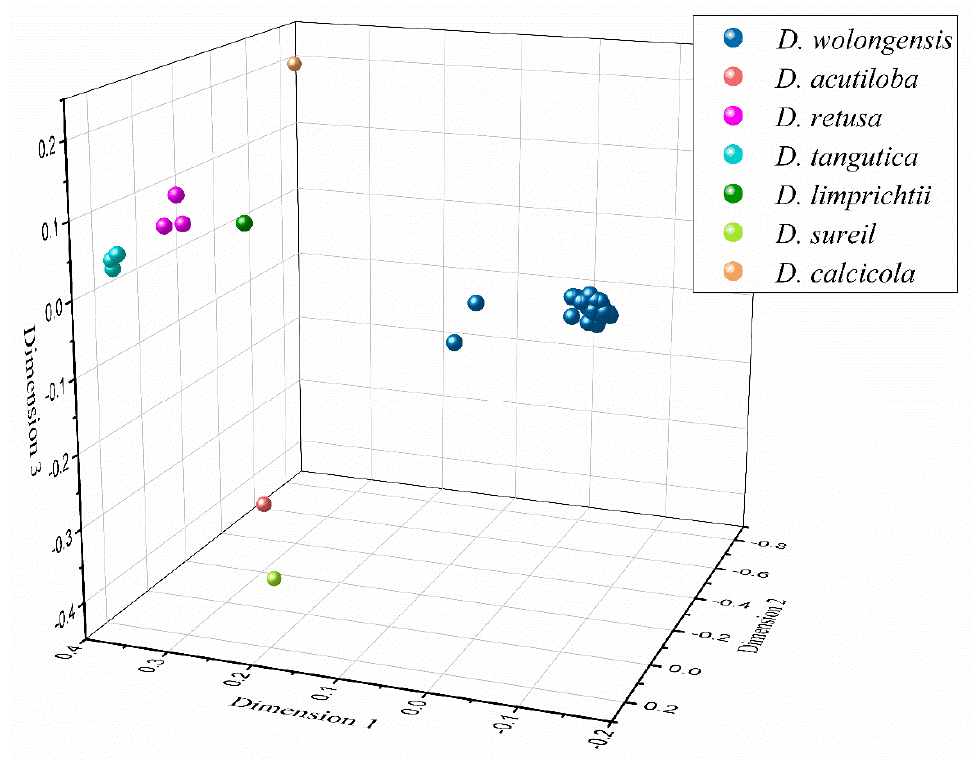
Figure 5. Principal Coordinate Analysis (PCoA) plot of 38 Daphne spp. individuals based on AFLP data.